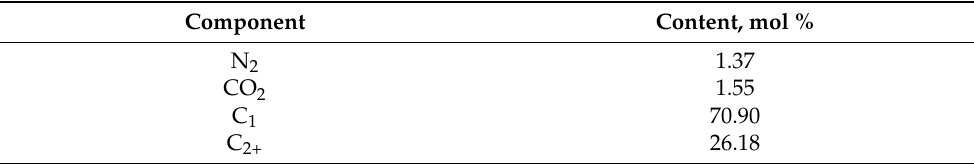
Table 3. Composition of APG injection gas mixture. Component